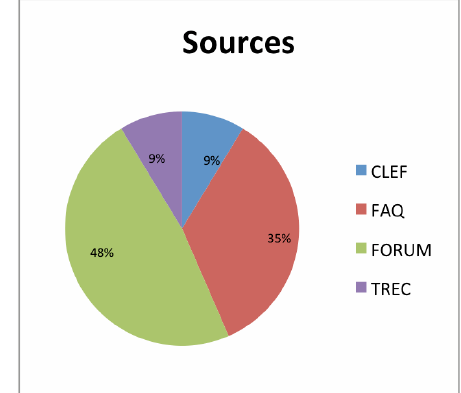
Figure 1. Source of the questions used for our corpus